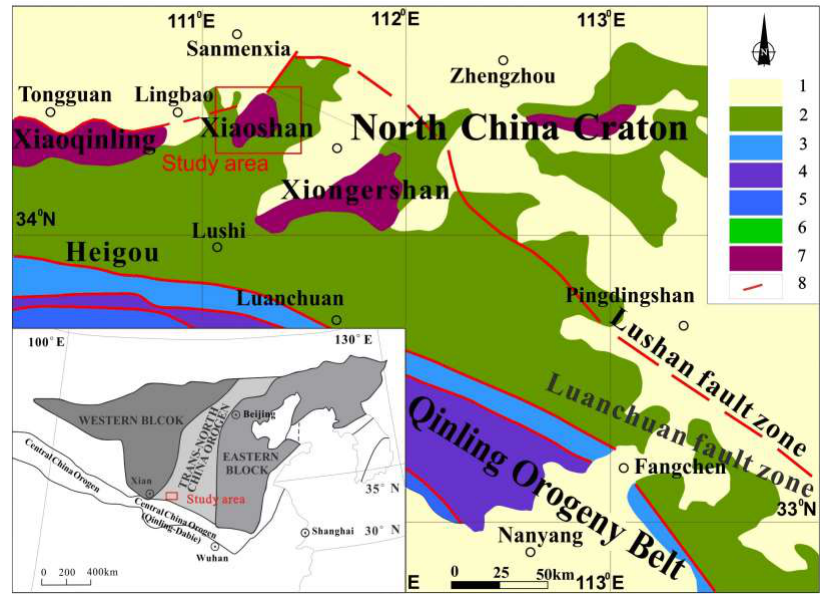
Figure 4. Geological map of the survey area [20]. (1) Quaternary; (2) Cover strata of the North China Craton; (3) Kuanping Group; (4) Erlangping Group; (5) Qinling Group; (6) South Qingling sequences; (7) Archean metamorphic rock; (8) Regional principal fault.